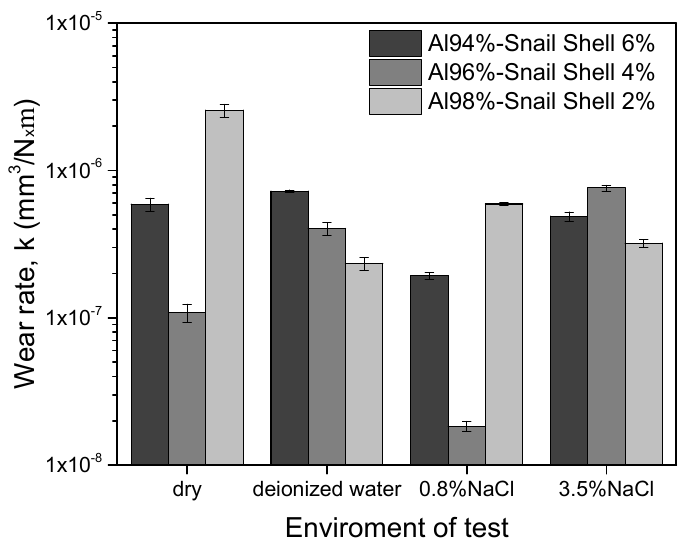
Figure 10. Wear rate for investigated samples in dry atmosphere, deionized water, 0.8% and 3.5%NaCl (averaged values of 5 points on each wear track).